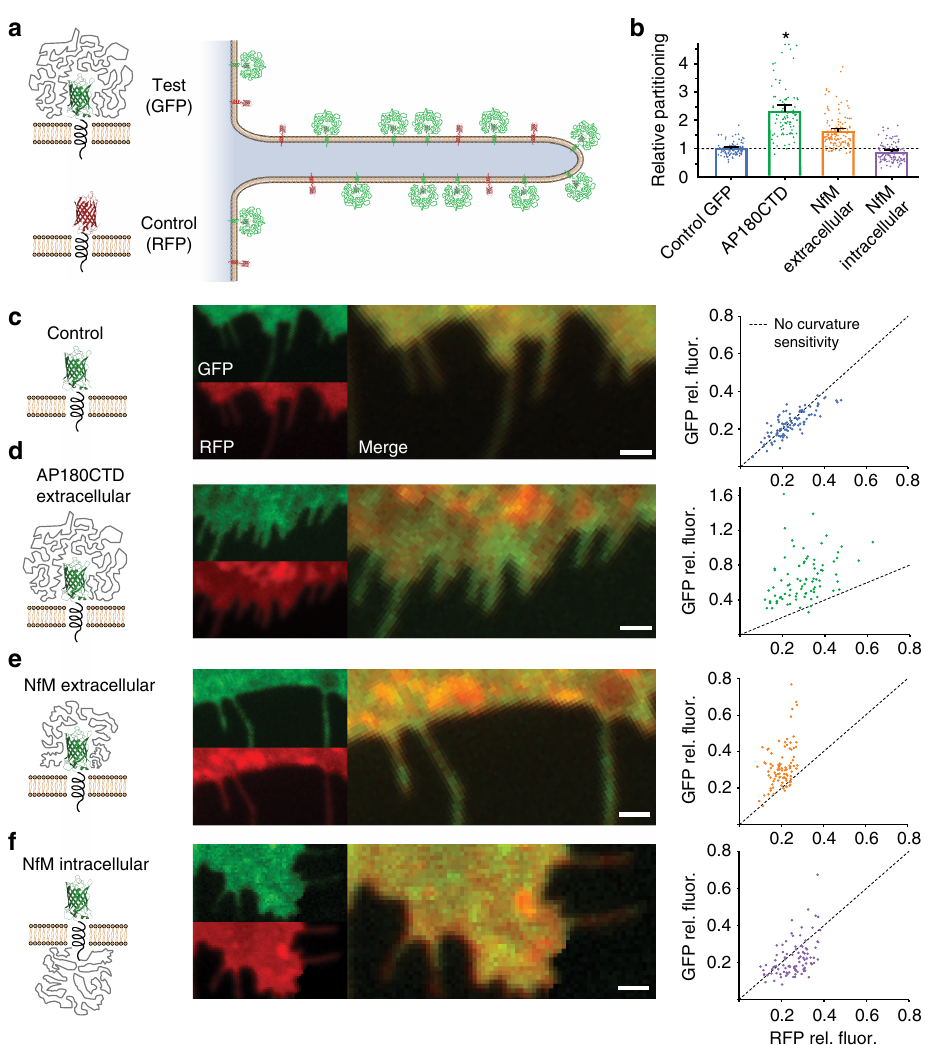
Fig. 4 Disordered proteins sense the curvature of fi lopodia in live cells. a Schematic of GFP and RFP partitioning on the outer membrane surface of live cells in the presence of fi lopodia when an IDP is attached to GFP. b Average change in fi lopodia partitioning for GFP-labeled proteins relative to RFP-labeled proteins. Error bars represent the 95% con fi dence interval of the mean for all fi lopodia within a given condition. N = 94, 85, 132, and 111 fi lopodia measured for control GFP, AP180CTD, NfM extracellular, and NfM intracellular proteins, respectively. Asterisk denotes two data points for the AP180CTD data set that extended beyond the range of the plot, having values of 5.8 and 7.8. c – f Structure, fl uorescence microscopy images of fi lopodia, and plots of relative GFP versus RFP fl uorescence on fi lopodia for control GFP, extracellular AP180CTD, extracellular NfM, and intracellular NfM, respectively. Scale bars in ( c – f ) represent 1 µ